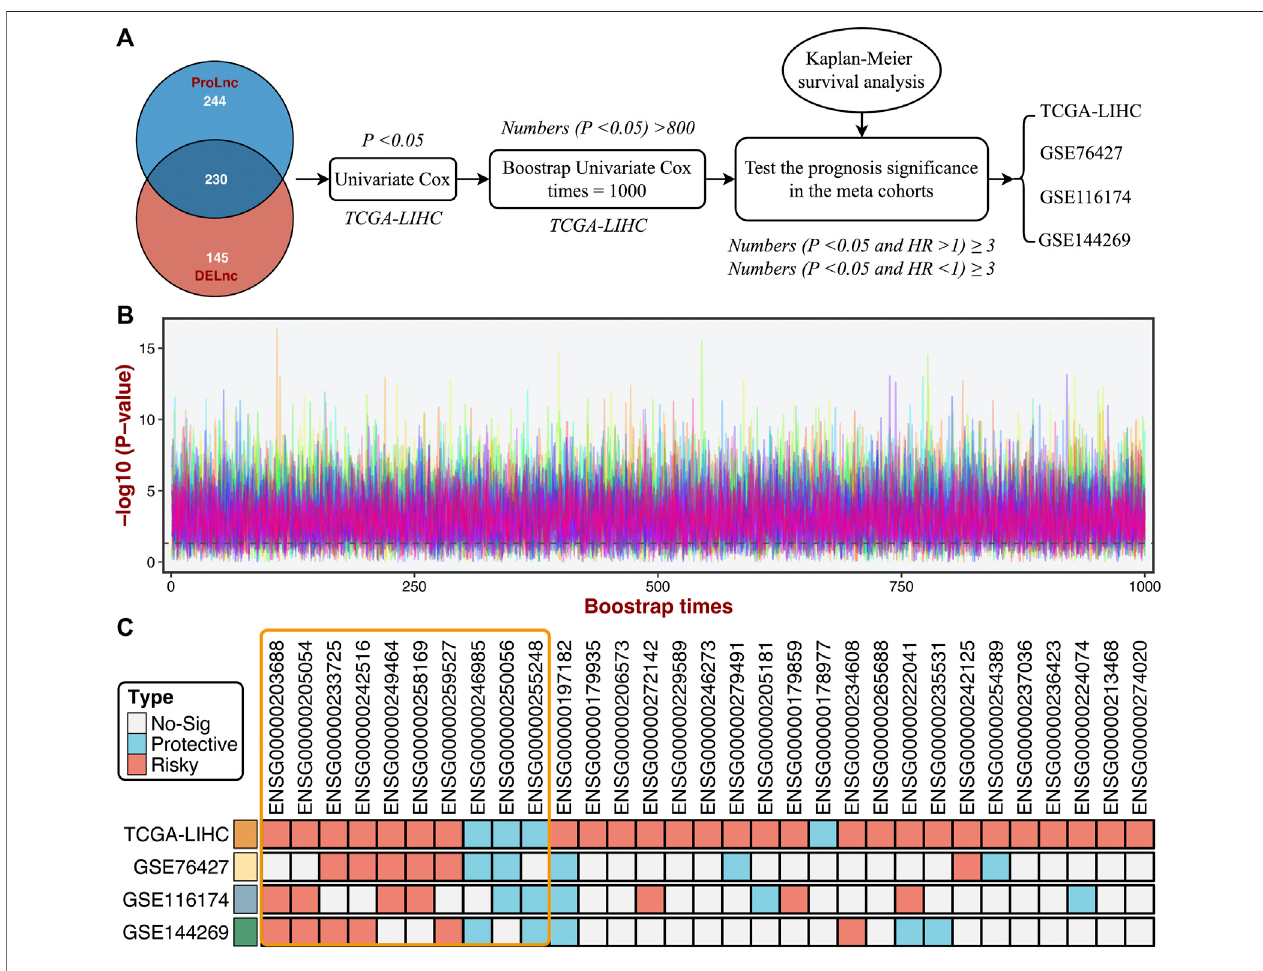
FIGURE 6 | Identifying the stable prognostic lncRNAs via bootstrapping univariate Cox regression analysis. (A) A multi-step pipeline to determine the regular prognosticPALs(SPPALs). (B) ThebootstrappingunivariateCoxregressionanalysiswasrepeated1000times,and31lncRNAsincorporatedin80%ofresamplingruns ( p < 0.05) were kept for subsequent analysis. (C) The prognostic signi fi cance of 31 lncRNAs in four cohorts.